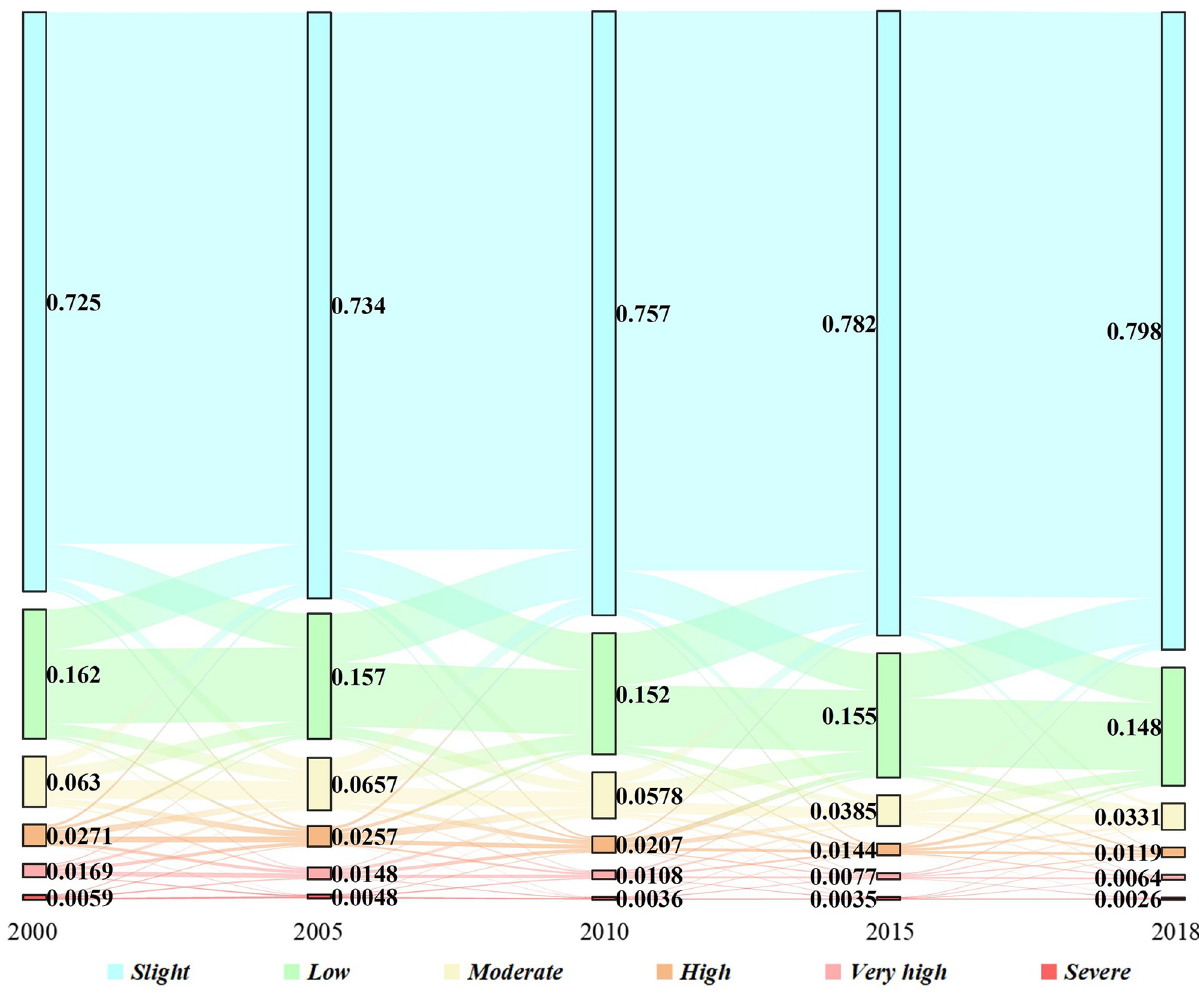
Fig 5. Change of the soil erosion intensity in the study area from 2000 to